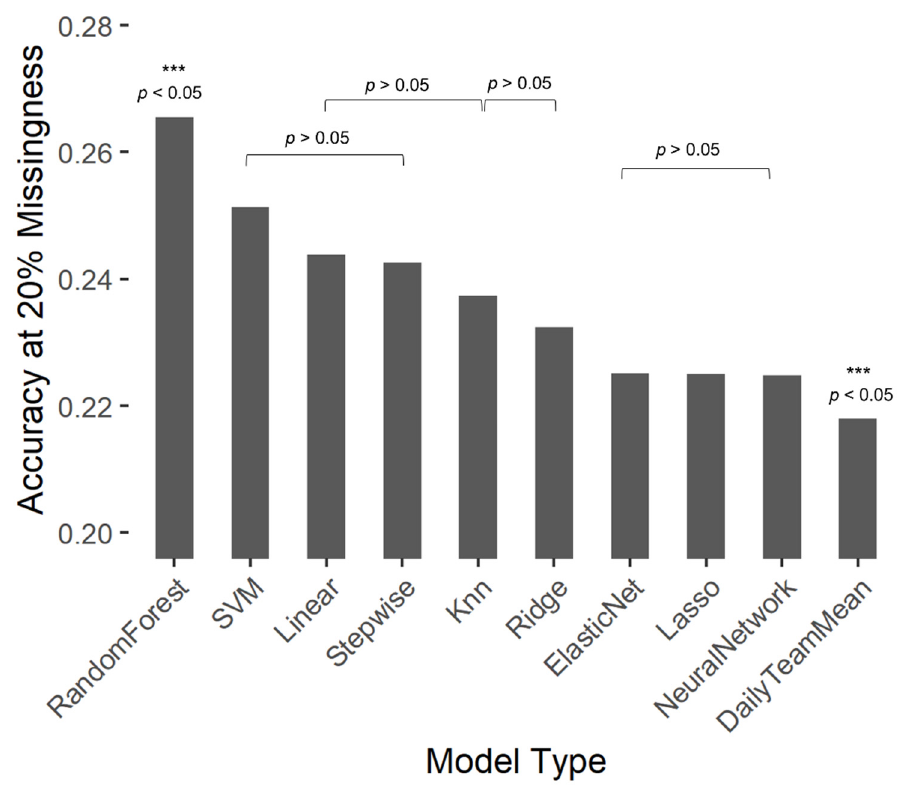
Mach. Learn. Knowl. Extr. 2022 , 4, FOR PEER REVIEW Figure 2. Model accuracy by type at 20% missingness, *** indicates significant difference. The accuracy of each model across cases of missingness is highlighted in Figure 3.